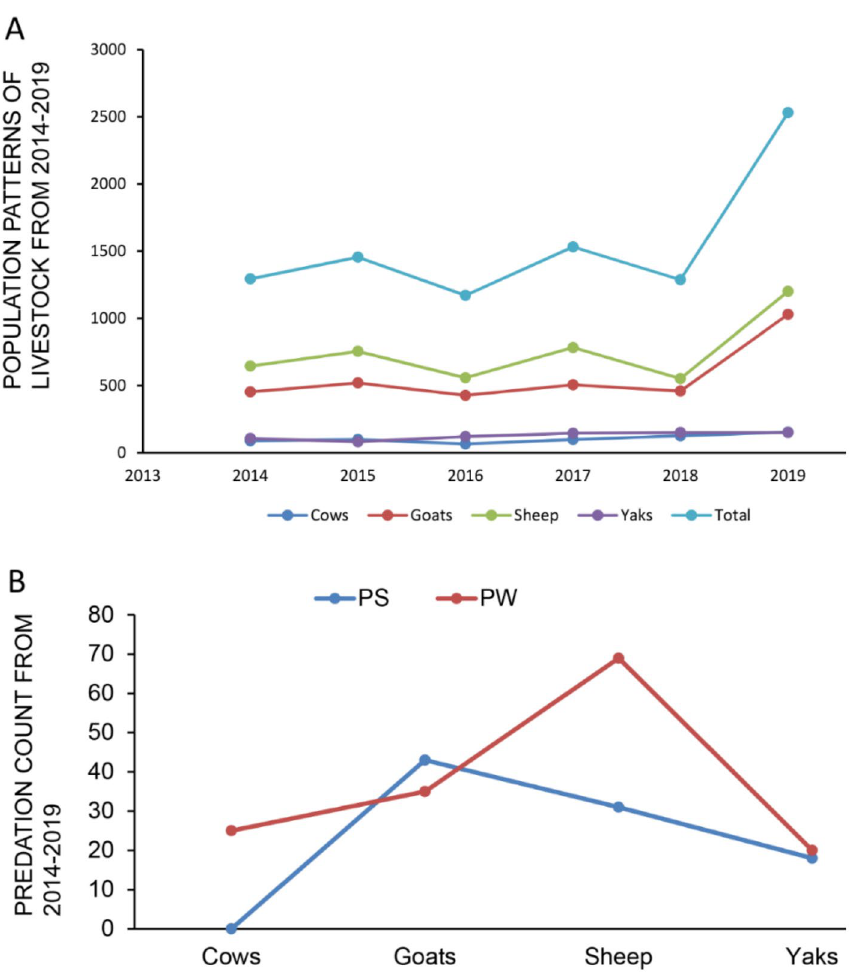
Figure 2. livestock population pattern and predation count. ( A ) Shows 5 years’ population patterns of livestock from 2014 to 2019. ( B ) Shows the predation count by snow leopard (PS), Predation by wolf